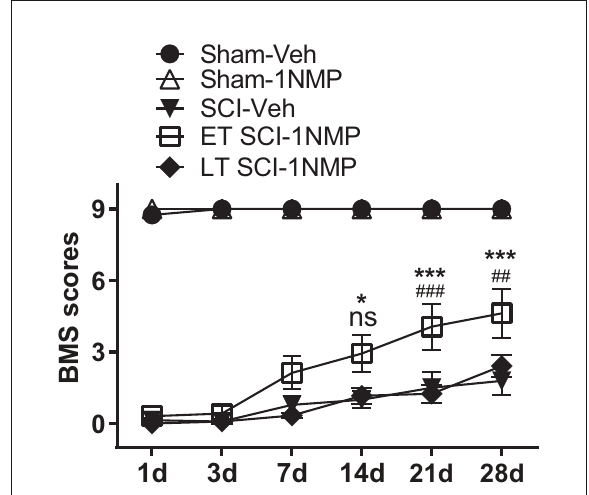
FIGURE5 Early inhibition of TrkB signaling with 1NMP improves locomotor recovery. SCI mice treated with 1NMP at 0–5 dpo had significantly improved BMS scores at 7, 14, 21 and 28 days comparedtoday1score( p < 0.0001;notindicated).Importantly, early 1NMP treated mice (ET SCI-1NMP) had higher BMS scores than late treated mice (LT SCI-1NMP, 16–21 dpo) at 21 dpo ( ### p < 0.001) and 28 dpo ( ## p < 0.01), and SCI-Veh mice at 14 dpo (* p < 0.05), 21 and 28 dpo (*** p < 0.001 in both cases), ns indicates no significant difference between early and late treated SCI mice. SCI mice in all three groups had impaired locomotor function compared to Sham